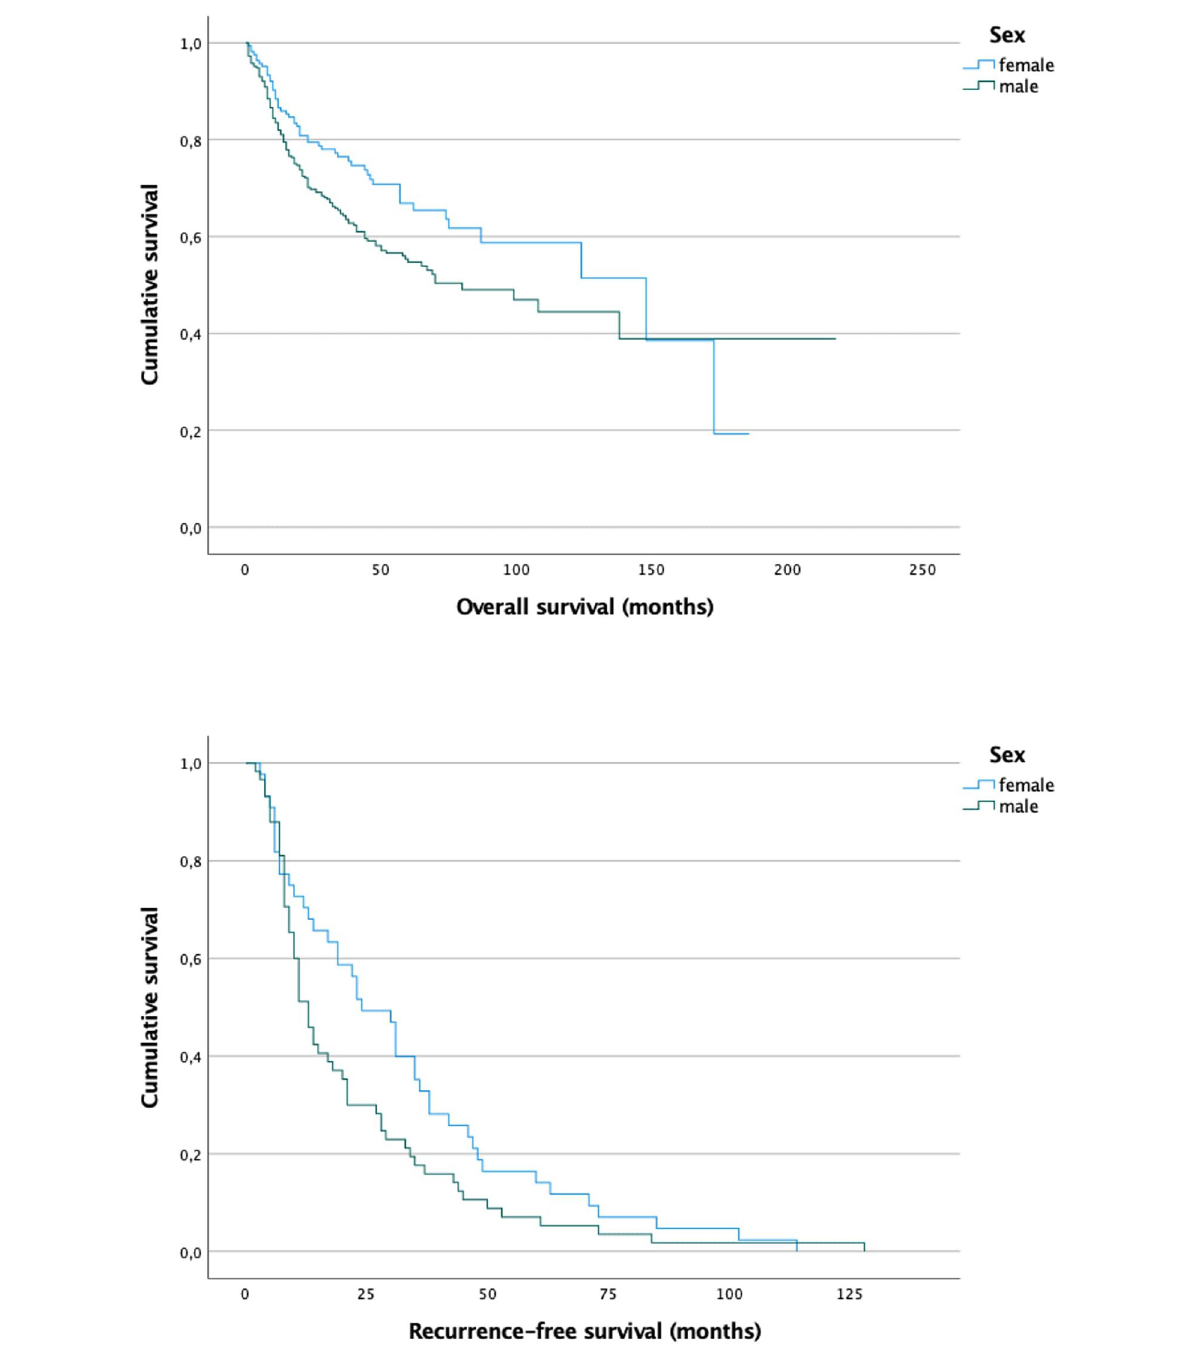
FIGURE3 Survival curves for male patients (mean overall survival 9.2 years) and female patients (mean overall survival 9.2 years) show a slight but significant difference in overall survival ( p = 0.016), while recurrence-free survival slightly misses significance ( p = 0.068).